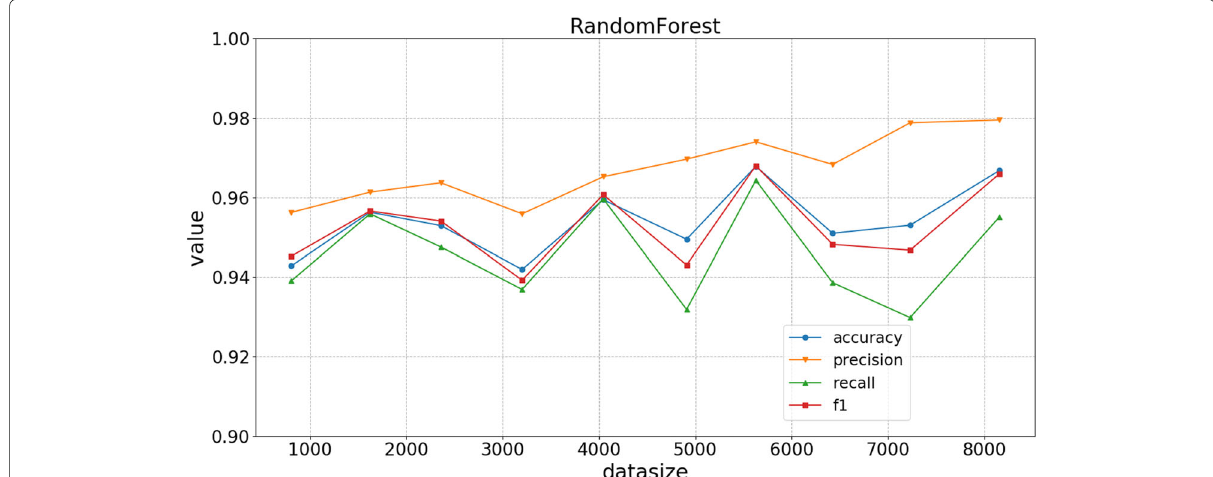
Fig. 14 Result of RF with different training set size. We test the Random Forest classifier using subsets with the following sizes: 803, 1622, 2357, 3201, 4043, 4909, 5628, 6425, 7230, and 8155, where the ratio of positive/negative is close to 1. The accuracy is high, which is above 95%. With the increase of the data size, the results get